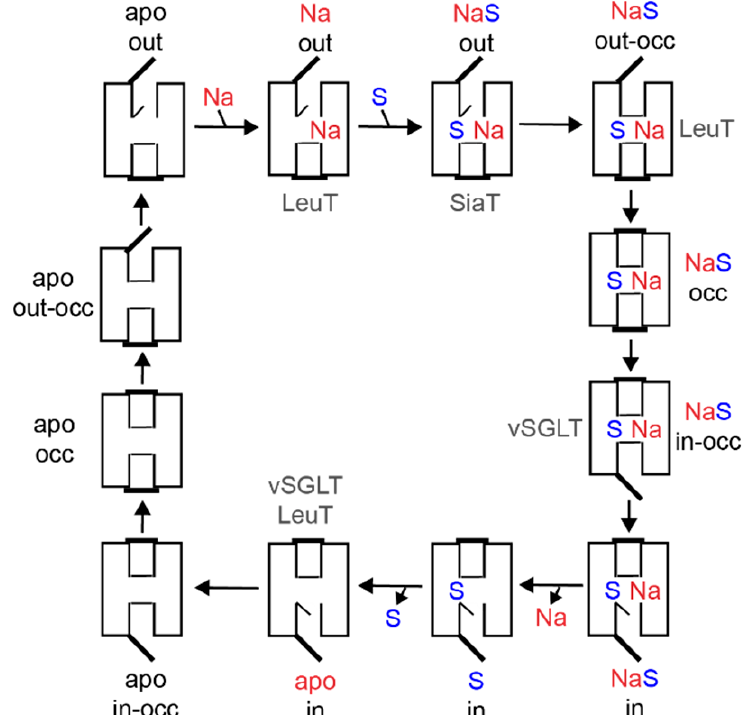
Figure 4. Model of conformational states underlying the alternating access mechanism of SSS family transporters and other transporters with a LeuT-type structural fold. The conformational states observed in crystal structures of vSGLT, PmSiaT and AaLeuT are indicated. Comprehensive kinetic analyses particularly with SGLT [2] and to some extent with PutP [106] propose an ordered binding mechanism. Sodium ions bind first to the transporter in the outward-open apo state inducing a conformational alteration that facilitates substrate binding. The ion-substrate-protein complex undergoes further conformational alterations that lead, via an occluded state, to an opening of the ion and substrate binding sites towards the inside of the cell, and finally, to the release of both ligands into the cytosol. The resulting inwardly oriented apo state of the transporters changes to the outward-open conformation to allow for a new transport cycle. Reciprocal opening and closing of inwardly and outwardly oriented cavities may involve movement of thin gates (vSGLT: Y263; PmSiaT: I67, F78; AaLeuT: Y108, F253), rearrangements of interactions between TMDs as well as between TMDs and inner and outer loops (for example the loop connecting TMDs 7 and 8 [11,64,84]. out: outward-open conformation, occ: occluded conformation, in: inward-open conformation. The SSS family transporter vSGLT has been crystallized in two conformations: (1) nward- occluded state with galactose bound to the center of the core domain (vSGLT-wild type, PDB: 3DH4) and (2) inward-open apo-state (vSGLT-K294A, PDB: 2XQ2) [83,84]. The pathway to the outside is blocked by a hydrophobic “thin” gate formed by M73 (cTMD1), Y87 (cTMD2) and F424 (outer end of cTMD10) and located directly above the central substrate binding site. In addition, interactions between the outer halves of cTMDs 1, 2, 6 and 10 and the loops connecting cTMDs 1 and 2, 7 and 8, and 9 and 10 (“thick” gate) prevent access to the central binding site. The hydrophilic pathway from the central substrate binding site to the cytoplasmic side of the transporter is (partially) open and lined by the inner portions of cTMDs 1, 2, 3, 6, and 8 [83,84]. In the inward-occluded state, access to the central substrate binding site is blocked by Y263 (cTMD6) that appears to function as an inner “thin” gate (Figure 3B). Comparison of the crystal structures, molecular dynamics simulation, and functional biochemical analyses led to the hypothesis that the transition from the outward- to the inward-occluded state of vSGLT alters the coordination of sodium at the Na2 leading finally to the release of sodium on the inner side of the transporter. Subsequent conformational changes including a movement of cTMD1 disrupt a hydrogen bond